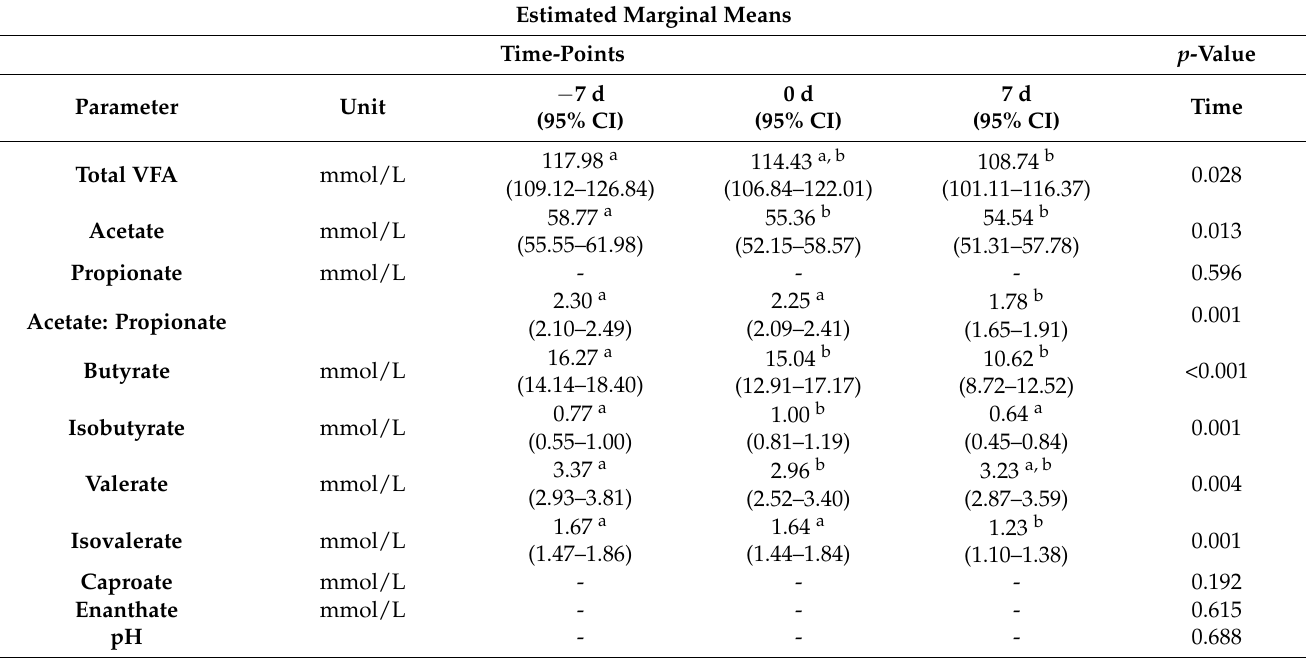
Table 3. Estimated marginal means (EMM) of volatile fatty acid (VFA) concentration and pH at 3 time-points ( − 7 d: 7 days pre-weaning, at 0 d: weaning and 7 d: 7 days post-weaning) from 243 Holstein calves of eight commercial dairy farms.